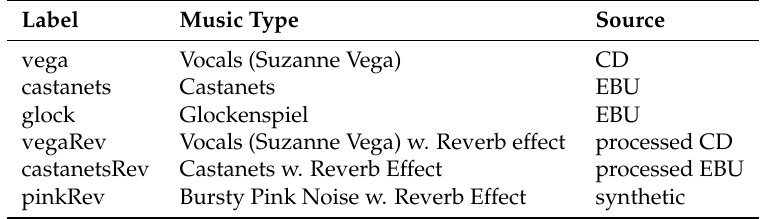
Table 1. Samples used during single point audio listening tests (reproduced from [3]).